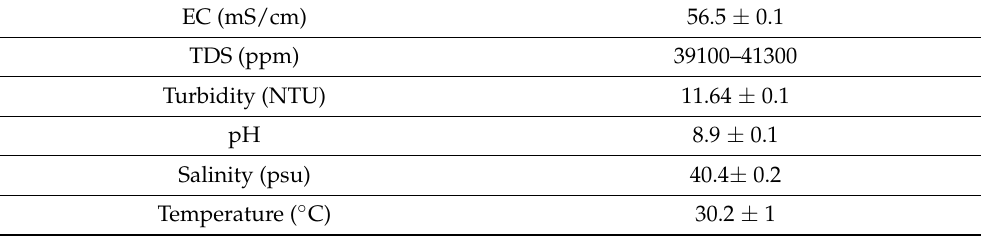
Table 2. Specifications of the